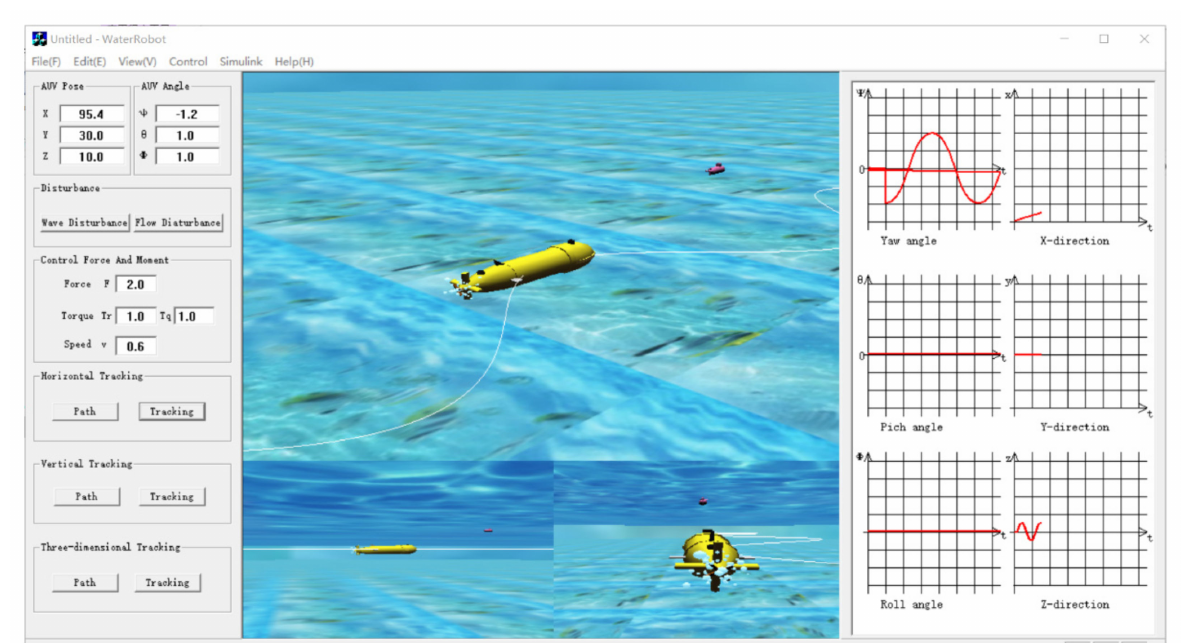
Figure 12. Virtual simulation of the AUV’s horizontal path tracking motion